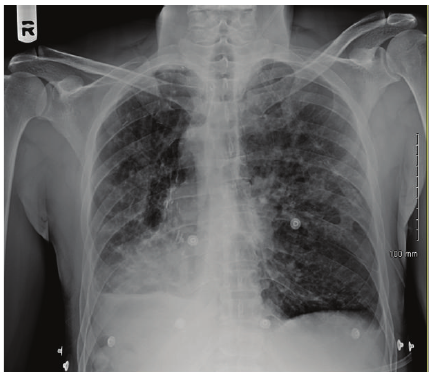
Figure1:Chestradiographshowingdextrocardiaandchronicinter- stitial markings from Kartagener’s syndrome.